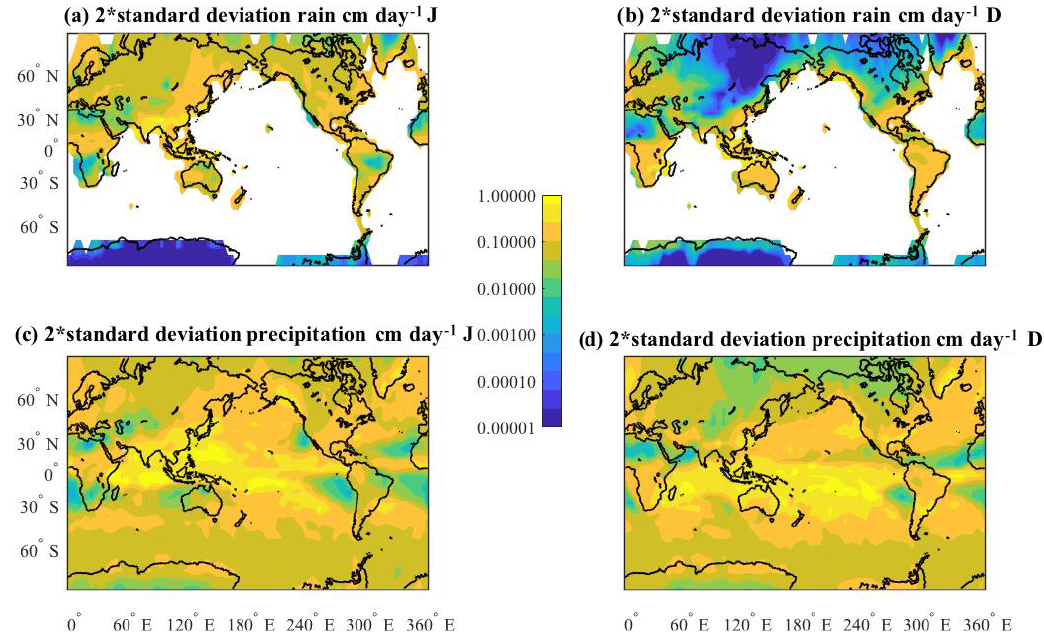
Figure 4. Maps of 2 standard deviations for representing uncertainty (2 σ ic ) for June (a, c) and December (b, d) of the 10th year of the simulations in (a, b) rain (land) field (cmday − 1 ) and (c, d) total precipitation (cmday − 1 ). (The shading is in terms of a log 10 value with tick marks labeled with unlogged